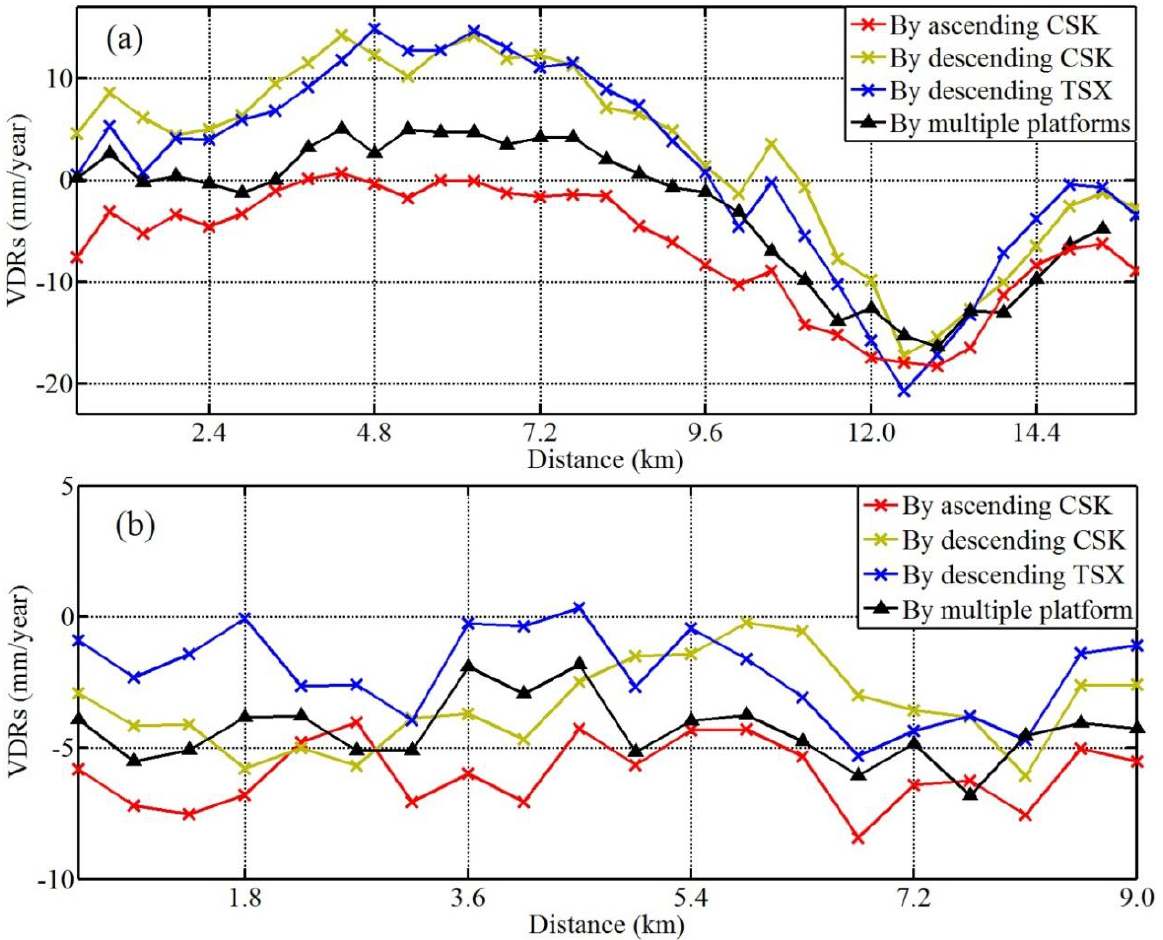
Figure 7. The comparisons of the profiles of VDRs derived from processing of the single- and multi-platform SAR images along the lines AA′ ( a ); and BB′ ( b